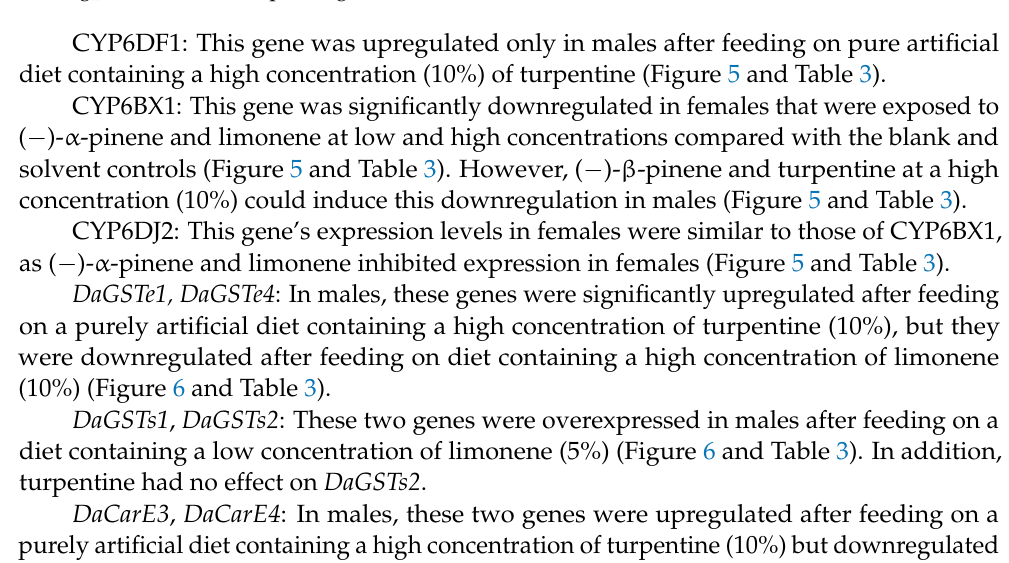
Figure 5. Realtime qPCR analysis of four P450 genes relative expression (mean ± SE) in D. armandi after fed on pure artificial feed with stimuli at different concentrations for 24 h. Values > 1 on the logarithmic y-axis indicate upregulation. Gene expression was normalized with respect to the geometrical mean of β -actin and CYP4G55. Asterisks indicate significant differences between the blank control and the solvent control based on the independent sample t -test of each gene’s expression (** p < 0.01). Statistically significant differences in gene expression among concentrations are shown in Table 3. The 2 − ∆∆ Ct and SE values were log 2 transformed for